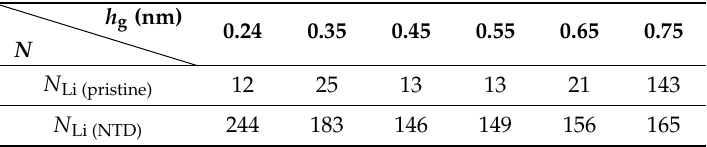
Table 5. Limit number of intercalated lithium atoms in silicene channels with a gap h g (not subjected and subjected to nuclear transmutation doping (NTD)).